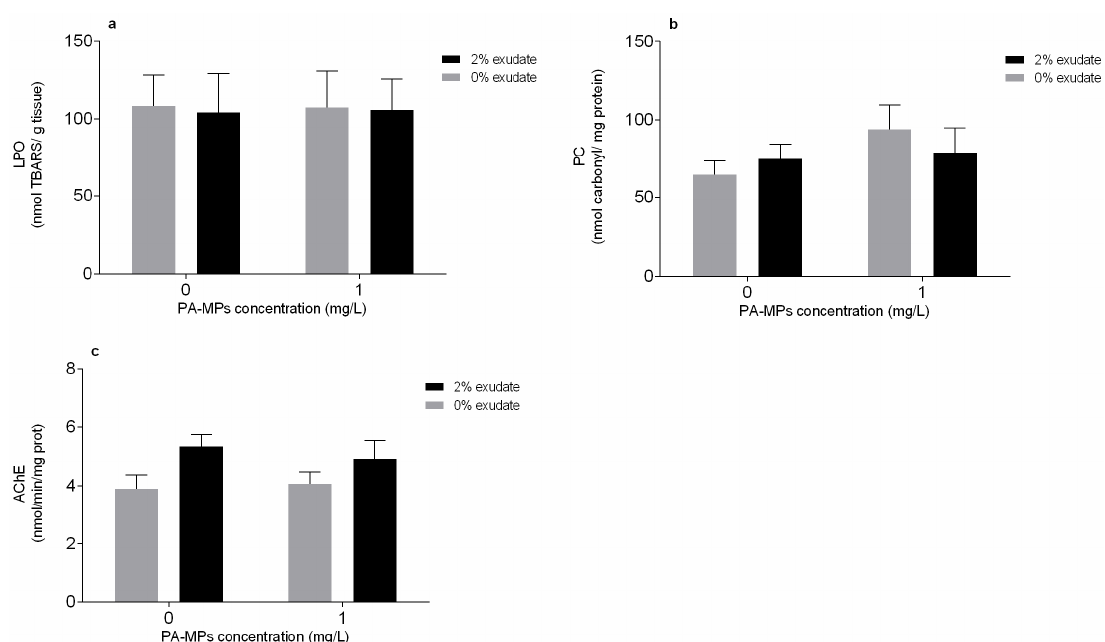
Figure 3. Oxidative stress-related biomarkers of Mytilus galloprovincialis muscles after 96 h of expo- sure to A. armata exudate (0% and 2%) at different polyamide microplastic (PA-MPs) concentrations (0 and 1 mg/L). ( a ) Lipid peroxidation (LPO), ( b ) protein carbonylation levels (PC), and ( c ) acetyl- cholinesterase activity (AChE). All values are presented as mean ± SEM.